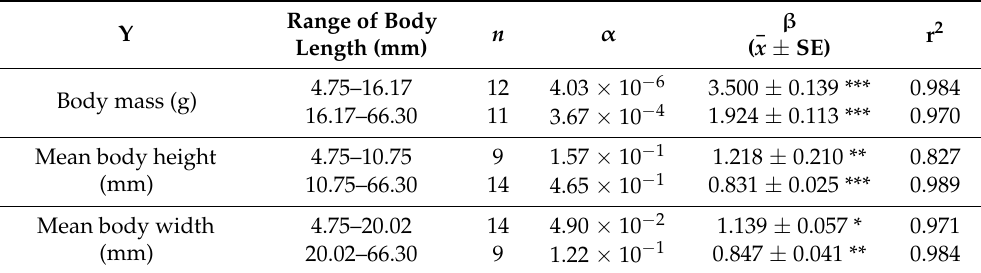
Table 3. Regression analyses of the allometric relationships (Y = α L β ) between body length (L) and body mass, mean body height, and mean body width (Y).